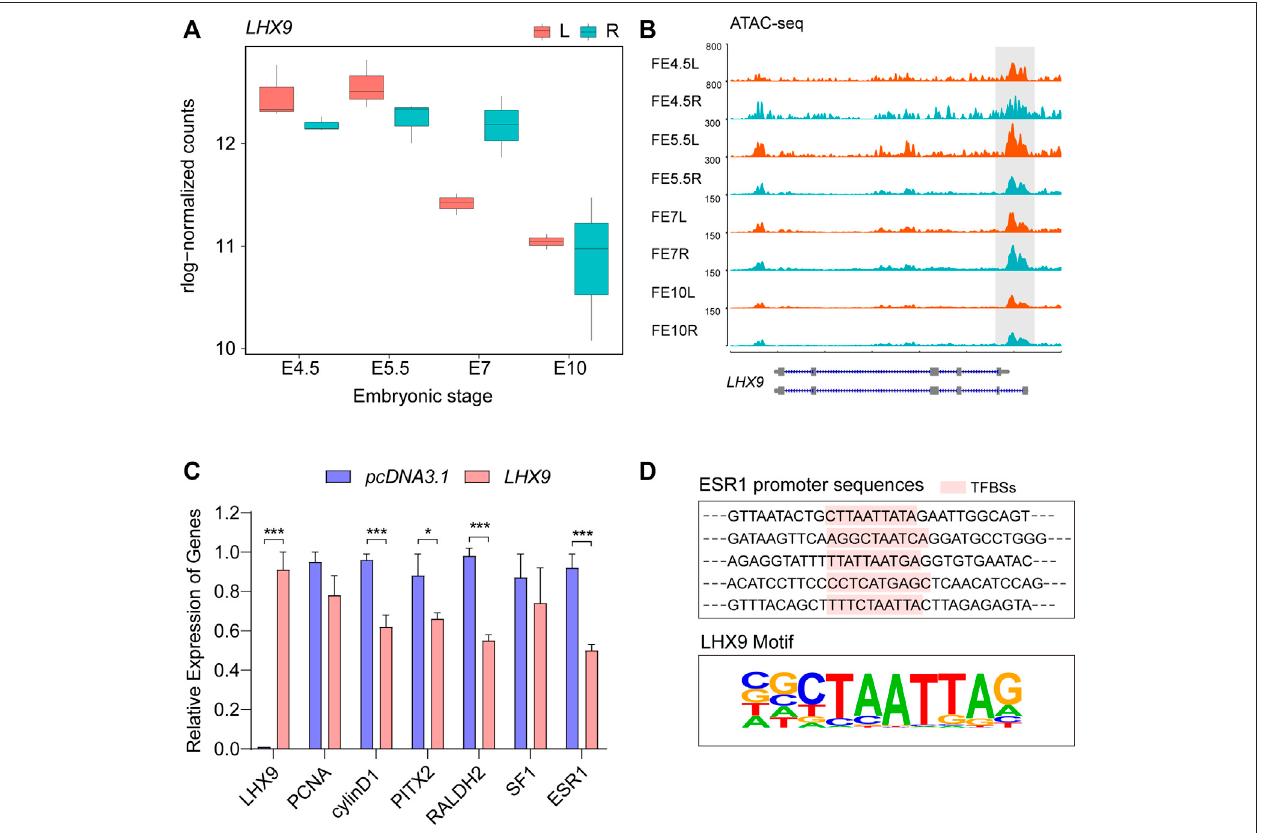
FIGURE4| Comprehensiveanalysisof LHX9 expression duringgonadaldevelopment. (A) Theexpression of LHX9 ateach stage.The x axisshowstheembryonic day,andthe y axisshowstherlog-normalizedcounts; (B) Chromatinaccessibilityofthe LHX9 geneateachstage; (C) Changesintherelativeexpressionofgenesrelated to asymmetric gonadal development in cells overexpressing LHX9 ; (D) The speci fi c TF (LHX9) binding sites (TFBSs) in the promoter regions of ESR1 .